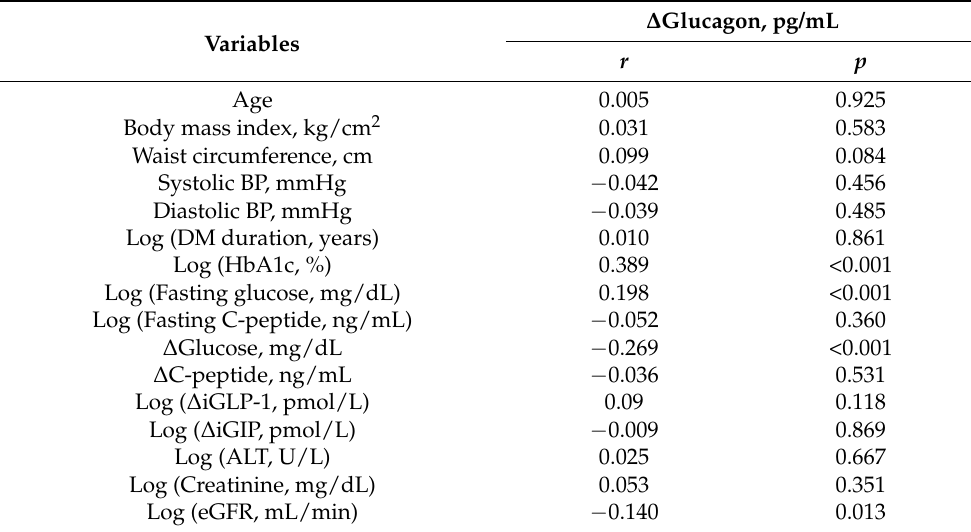
Table 3. Correlational analysis of the relationships between ∆ glucagon levels and clinical and laboratory variables ( n = 317).